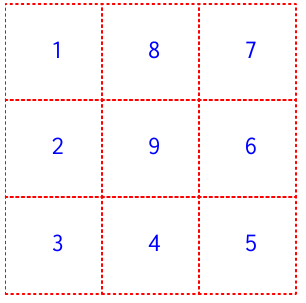
Figure 2. Mosaic-9 data augmentation.